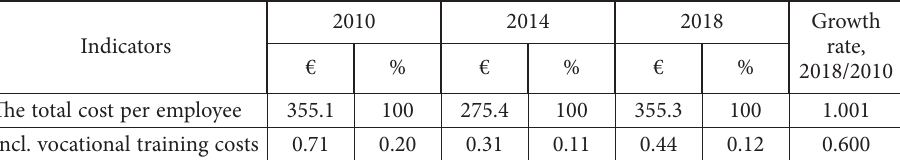
Table 2. Dynamics of labour costs and vocational training costs in Ukraine (source: Own calculations based on SSSU, 2020) Indicators